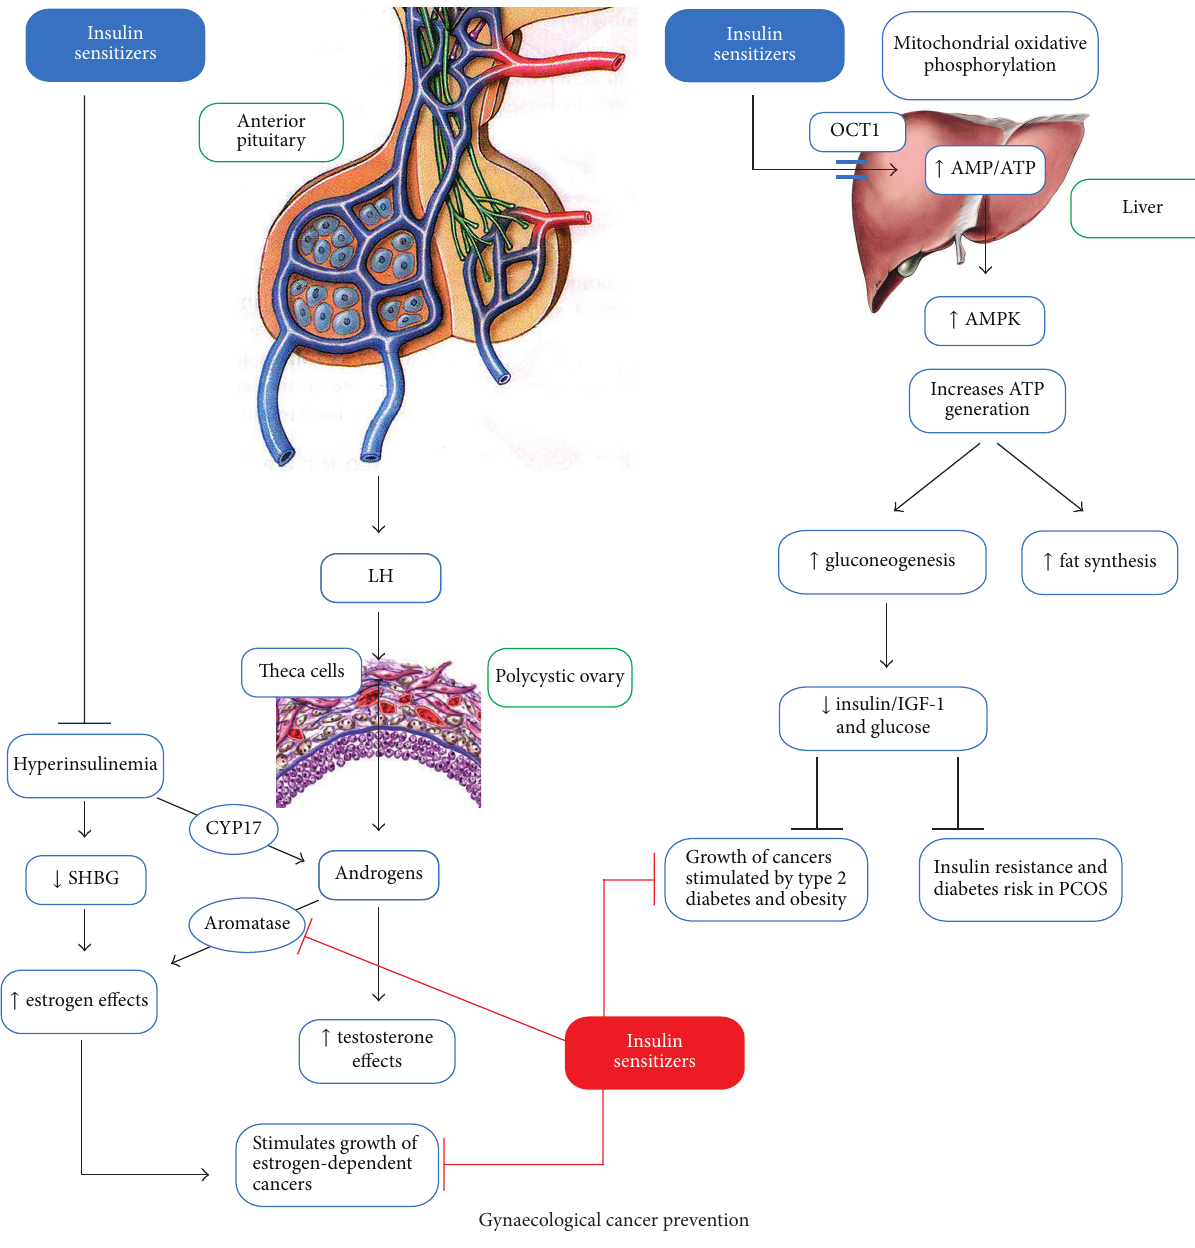
Figure 1: The combined action of insulin-sensitizers on the liver and ovary and the supposed protecting effect on endocrine-related gynaecological cancer. In the liver metformin inhibits mitochondrial respiratory complex 1 promoting AMPK activation which improves the metabolic profile reducing hyperglycemia, hyperinsulinemia, and insulin resistance. Insulin-sensitizers have a positive effect in PCOS patients through normalization of hyperinsulinaemia that otherwise amplifies the excessive androgen production from the ovary theca cells via CYP17 phosphorylation and lower levels of SHBG. Metformin and inositols may play an anticancer role both as insulin-sensitizers and as aromatase inhibitors. Indeed, they improve metabolic profile, inhibiting the growth of tumoural cells stimulated by hyperinsulinemia, and normalize estrogen production, inhibiting the growth of estrogen-dependent cancers. OCT1: Organic Cation Transporter 1; LH: luteinizing hormone; ISF-1: insulin sensitivity factor; CYP17: Cytochrome P-45017; SHBG: sex hormone binding globulin; IGF-1: insulin-like growth factor; PCOS: polycystic ovary